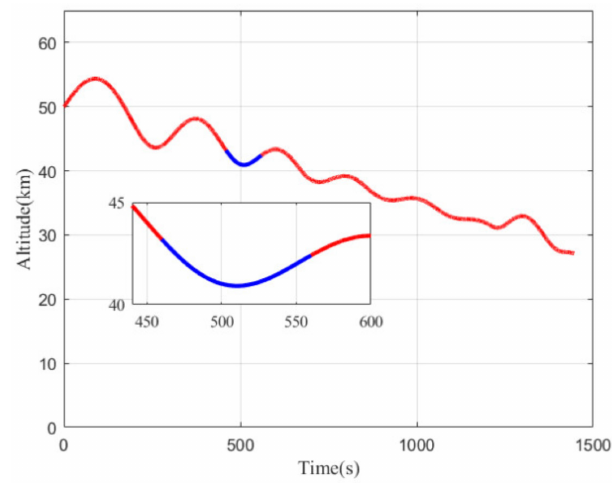
Figure 4. Trajectory in the longitudinal profile.